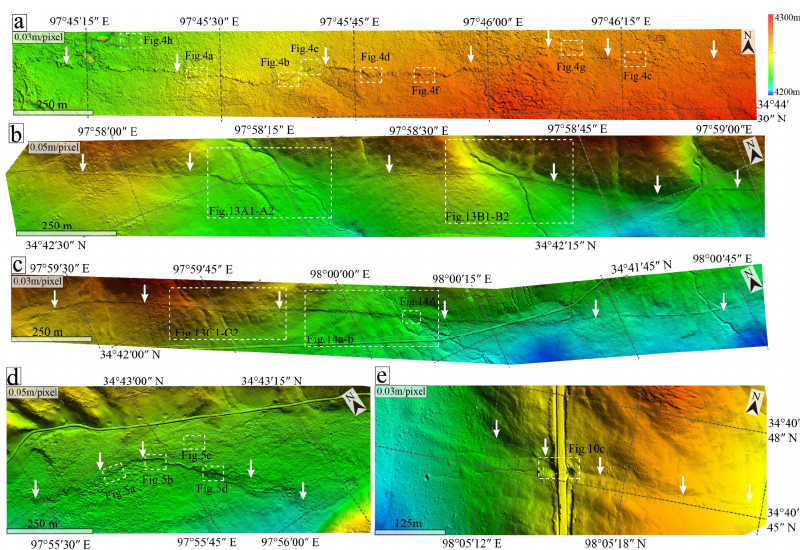
Figure 2. High-resolution DSM (3–5 cm/pixel) of typical co-seismic surface rupture of the Maduo earthquake obtained by UAV within three days after the earthquake. ( a – e ) are the aerially surveyed swaths of the DSM from west to east of the co-seismic surface rupture and the locations of Figures 4–14 are also indicated in ( a – e ). The white arrows indicate the co-seismic surface-rupture